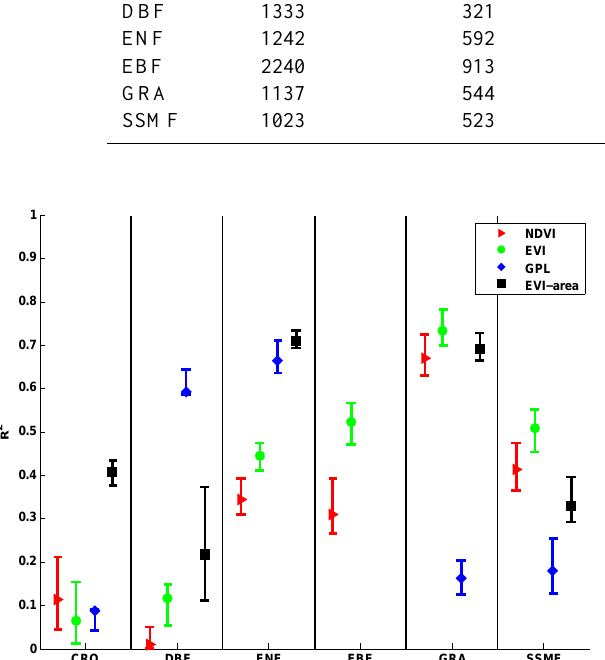
Fig. 3. R 2 between mean annual tower GPP and corresponding val- ues from the four different remotely sensed proxies of GPP. GPL and EVI-area were not used in